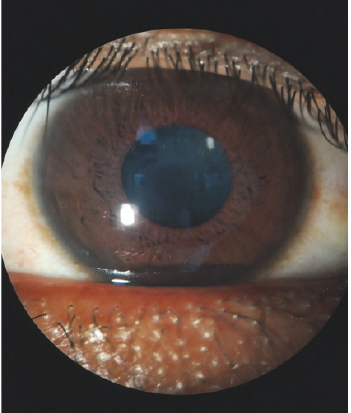
Figure 16: Magnified view of the eye through eyeSmart Cyclops.